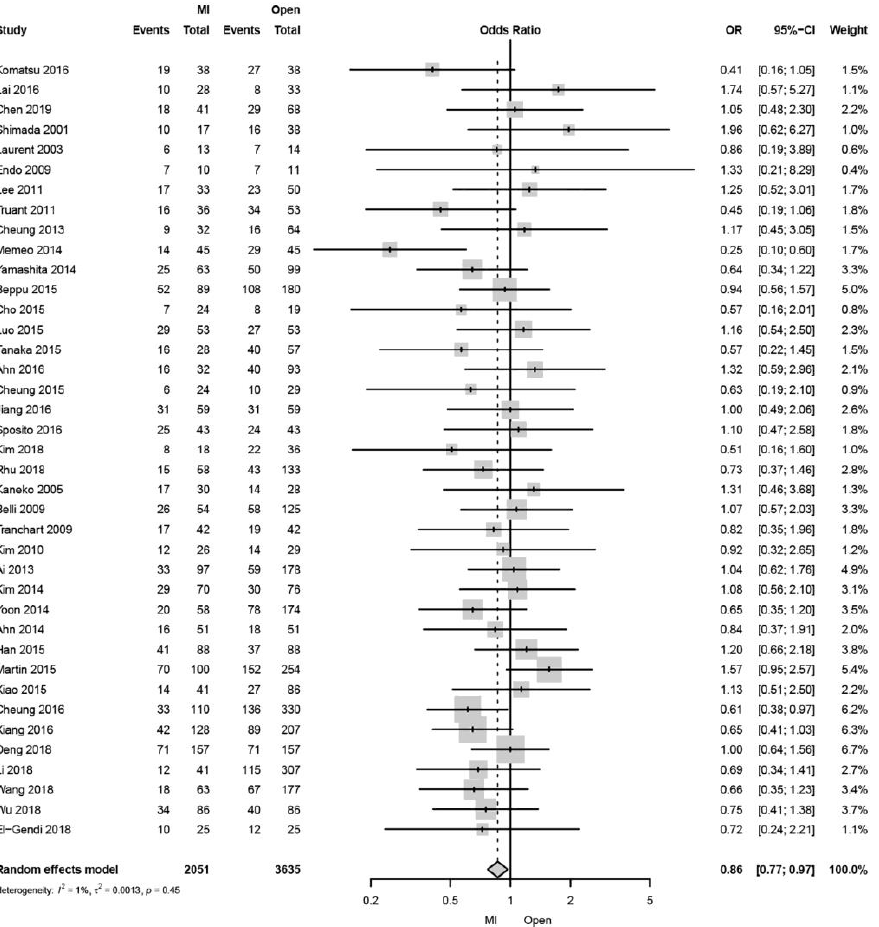
Figure 1. Forest plot of disease-specific 3-year mortality comparing minimally invasive and open